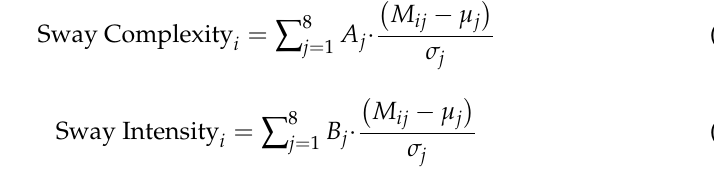
Table A1. Values of the parameters for the computation of sway complexity and sway intensity scores from the instrumented variables descriptive of instrumented modified Romberg test (Im- Romberg).